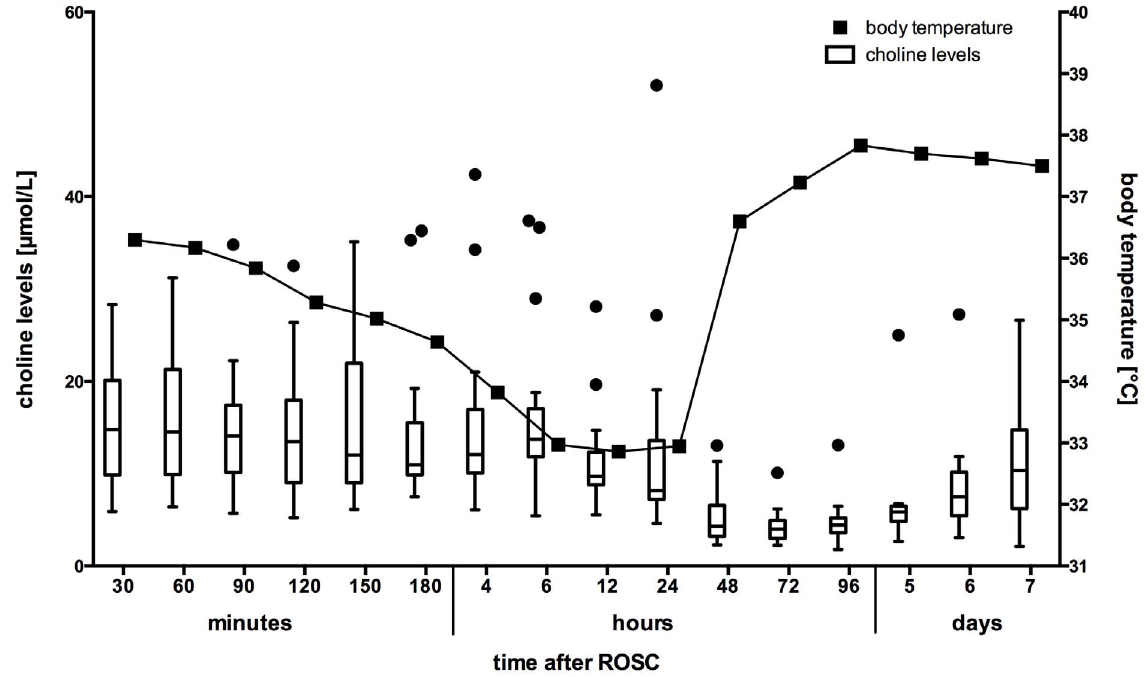
Figure 2. Changes of plasma free choline levels (median and interquartile range) in relation to the body temperature (median).